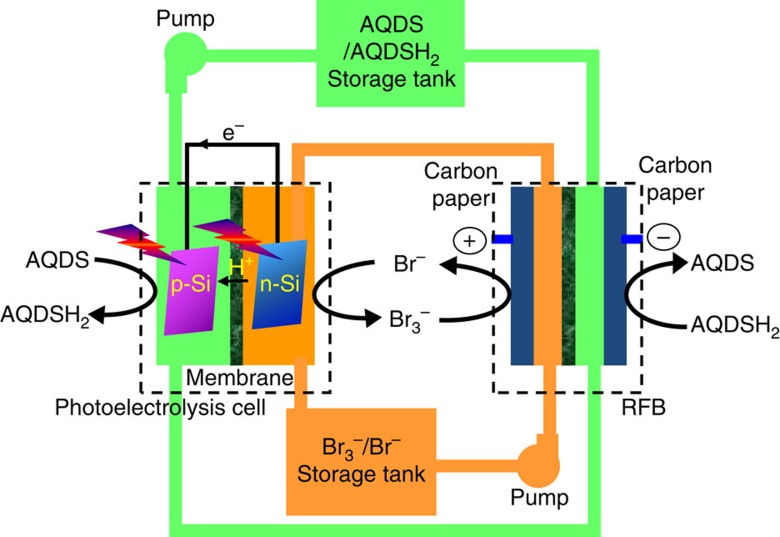
Schematic configuration of the proposed SRFC.AQDS/AQDSH2 and Br3−/Br− are used as redox couples.